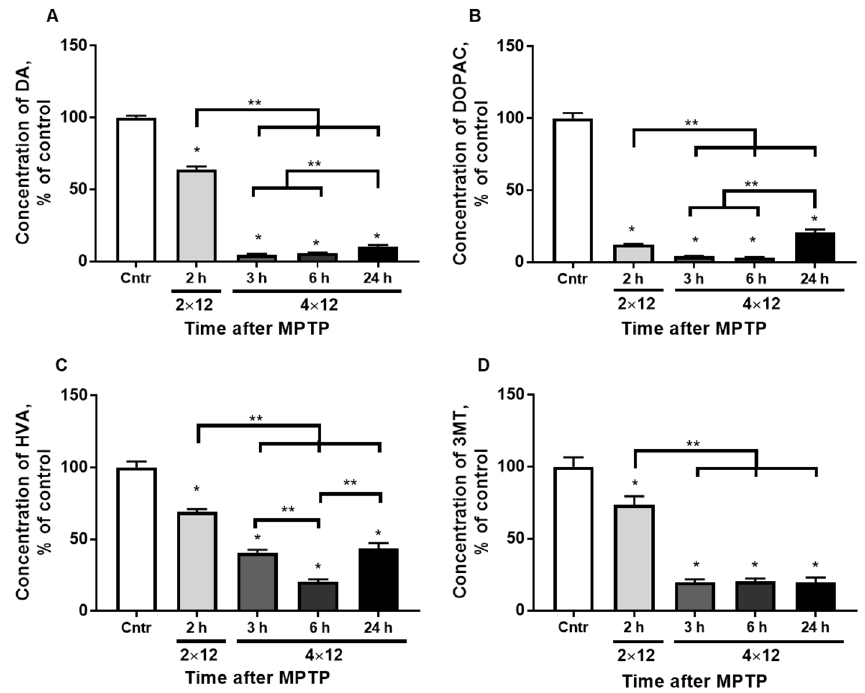
Figure 2. The concentration of DA ( A ), DOPAC ( B ), HVA ( C ), and 3MT ( D ) in the striatum of the control and 2 h after 2 × 12 mg/kg of MPTP and 3, 6, and 24 h after 4 × 12 mg/kg of MPTP. The results are presented as percentages of those of the control (100%). * p < 0.05 compared with the control (saline). ** p < 0.05 compared with selected MPTP groups.